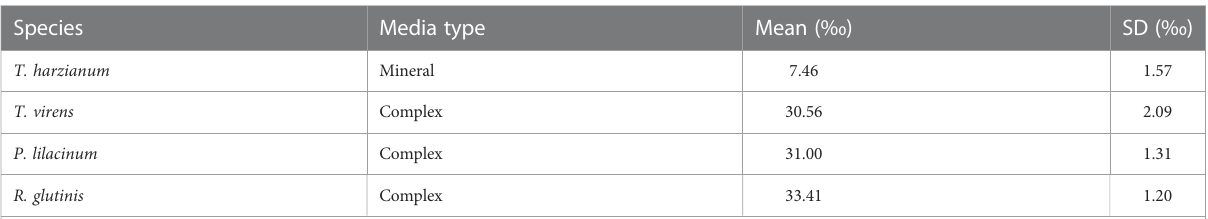
TABLE 1 The mean and standard deviation (n = 3) of N 2 O site preference (SP) produced by salt marsh sediment fungal strains from this study.